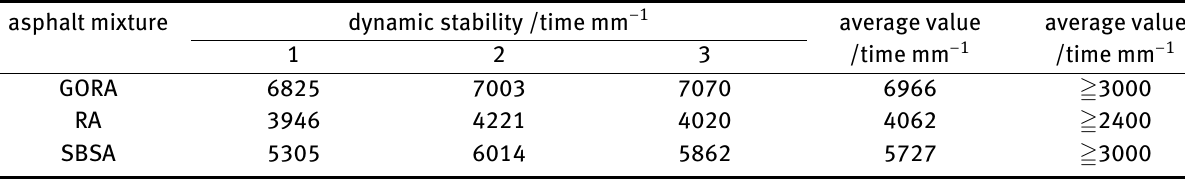
Table 6: Low temperature cracking test of GORA mixture Low temperature bending test